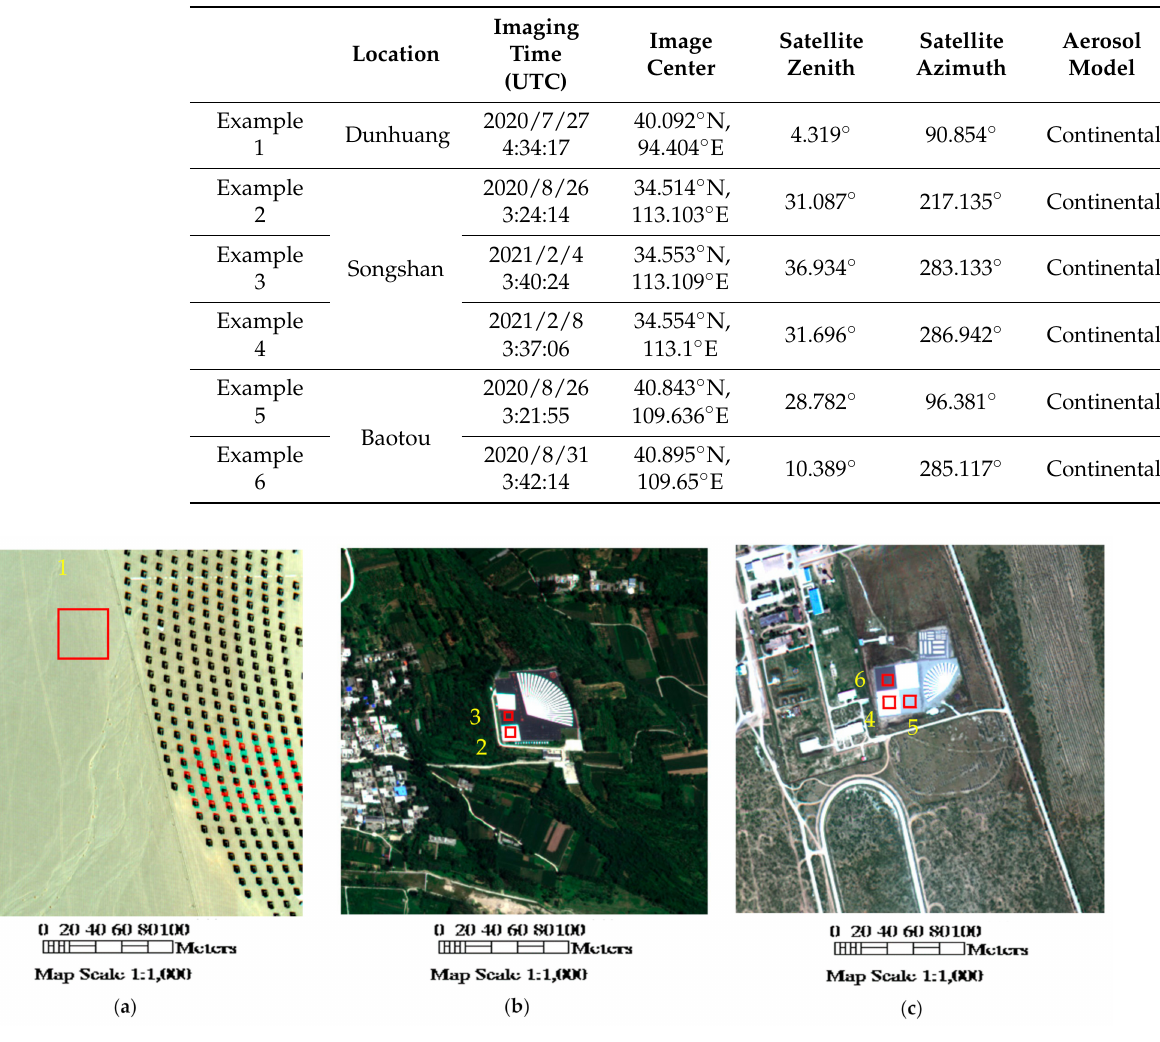
Figure 6. Study areas (marked with red square and number) of the radiometric calibration sites. ( a ) Sand of Dunhuang site. The small squares on the right side are solar panels. ( b ) White and black artificial targets of Songshan site. ( c ) White, gray, and black artificial targets of Baotou